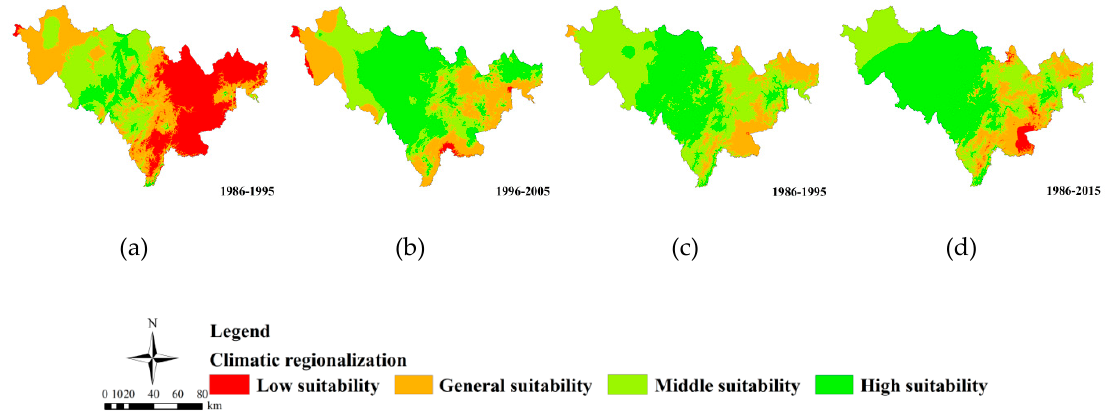
Figure 7. Temporal trends of mean suitability of differently maturing varieties ( a – c represent early maturity, middle maturity, and late maturity, respectively).